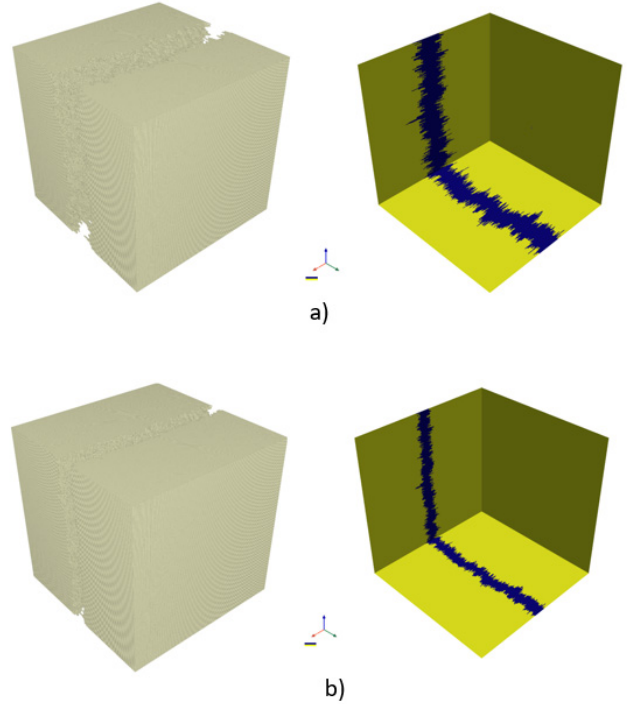
Figure 11. Digital rock with 256 samples and with ( a ) fractal exponent equal 2.5 and mean aperture of 44 ( b ) fractal exponent equal 2.5 and mean aperture of 22 [19].